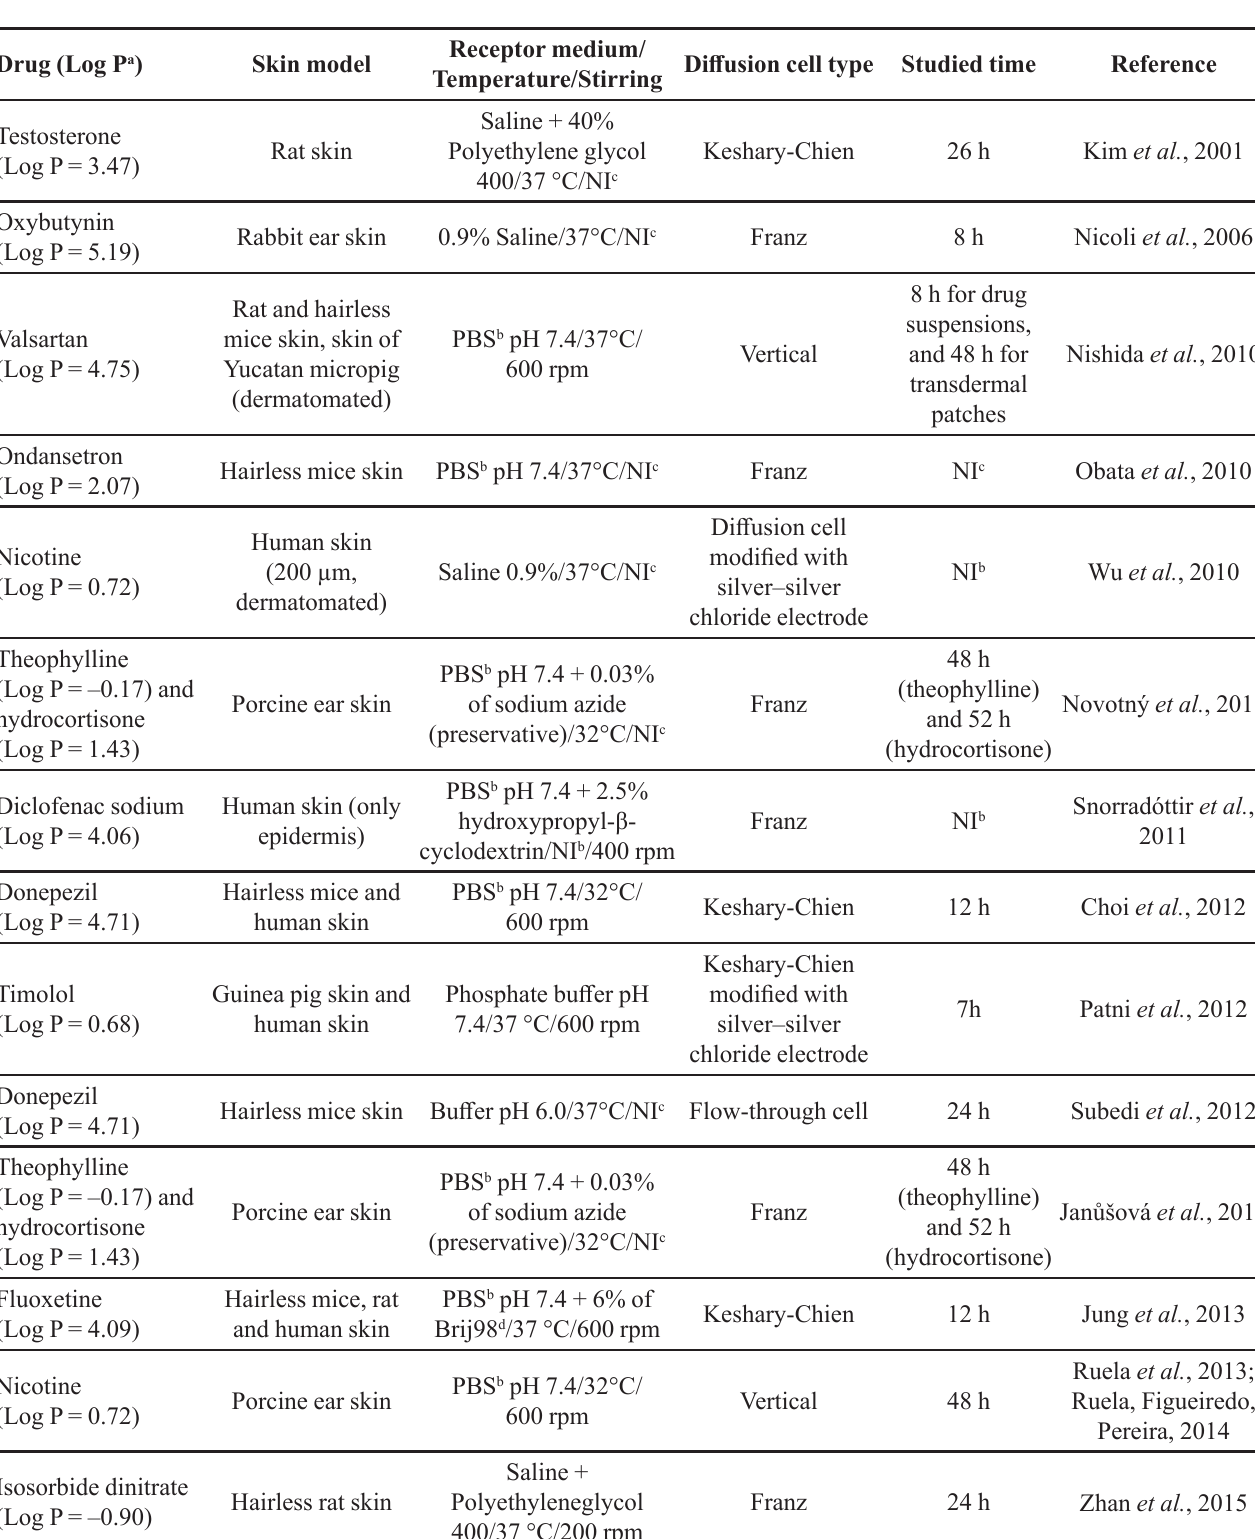
TABLE I - Some experimental conditions used for evaluation of in vitro skin permeation of